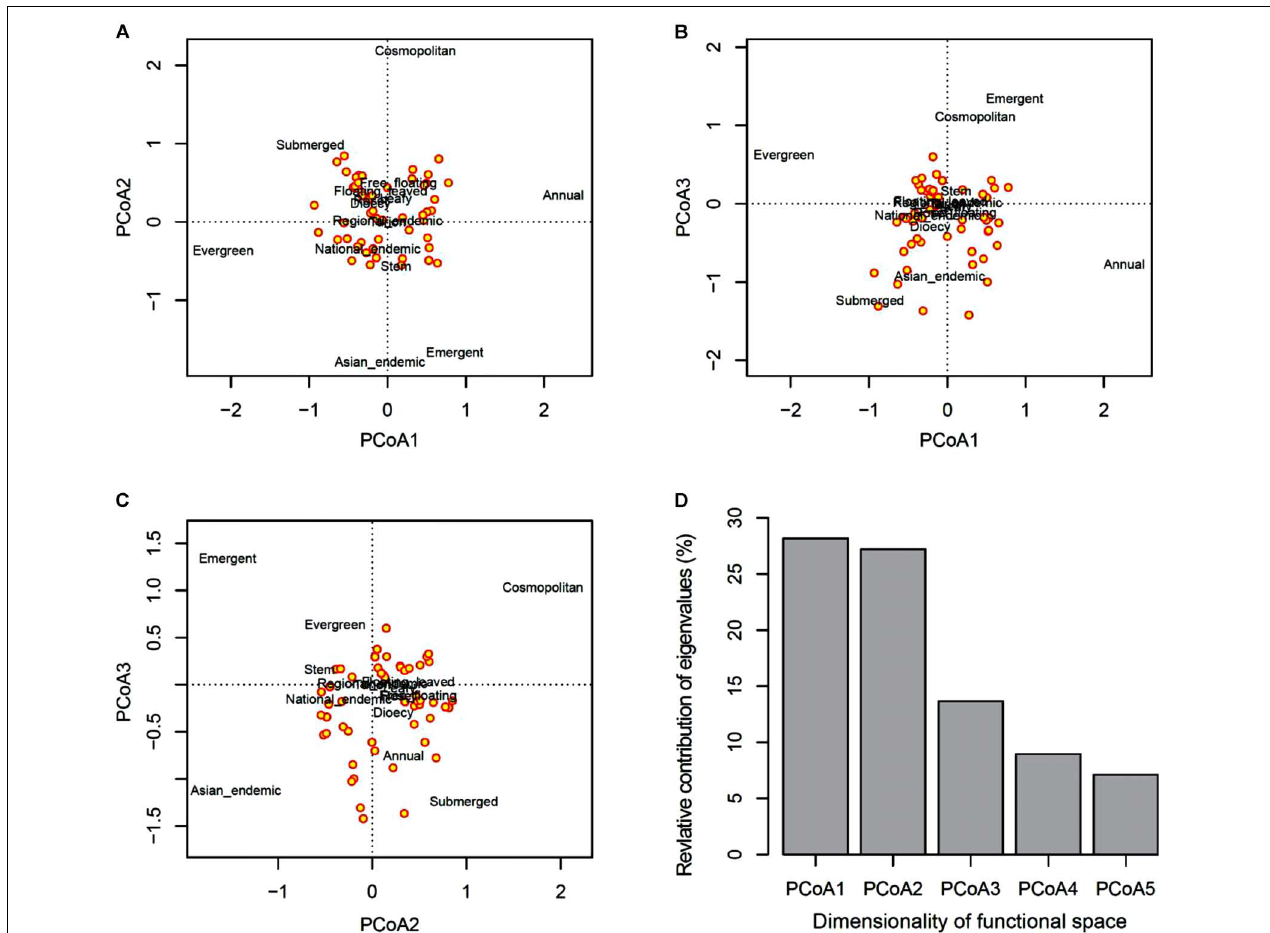
FIGURE 4 | Principal coordinates analysis (PCoA) of functional traits. Shown are (A–C) plots of assemblage pairwise comparison of the first three PCoA axes (factors) and (D) the relative contribution of eigenvalues of the first five PCoA